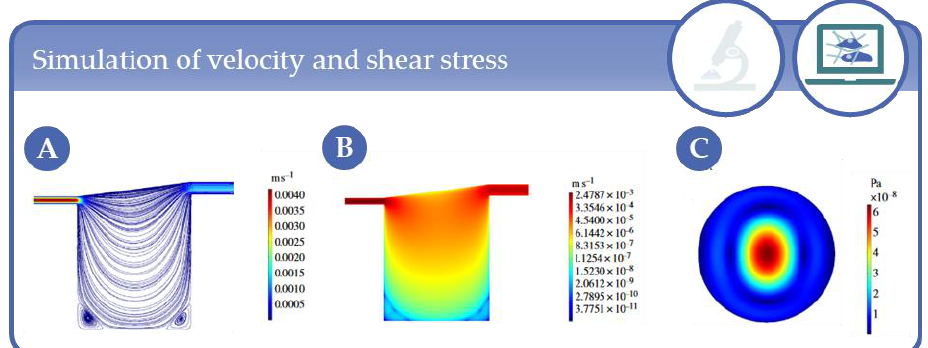
Figure 28. Simulation results for Q = 100 mL min −1 . ( A ) Streamlines and magnitude of velocity through the center of the chamber on the y,z-plane. ( B ) Magnitude of velocity through the center of the chamber on the y,z-plane using a log scale. ( C ) Magnitude of shear stress at the cell surface on the x,y-plane. Reprinted with permission from [244] by Royal Society Publishing.